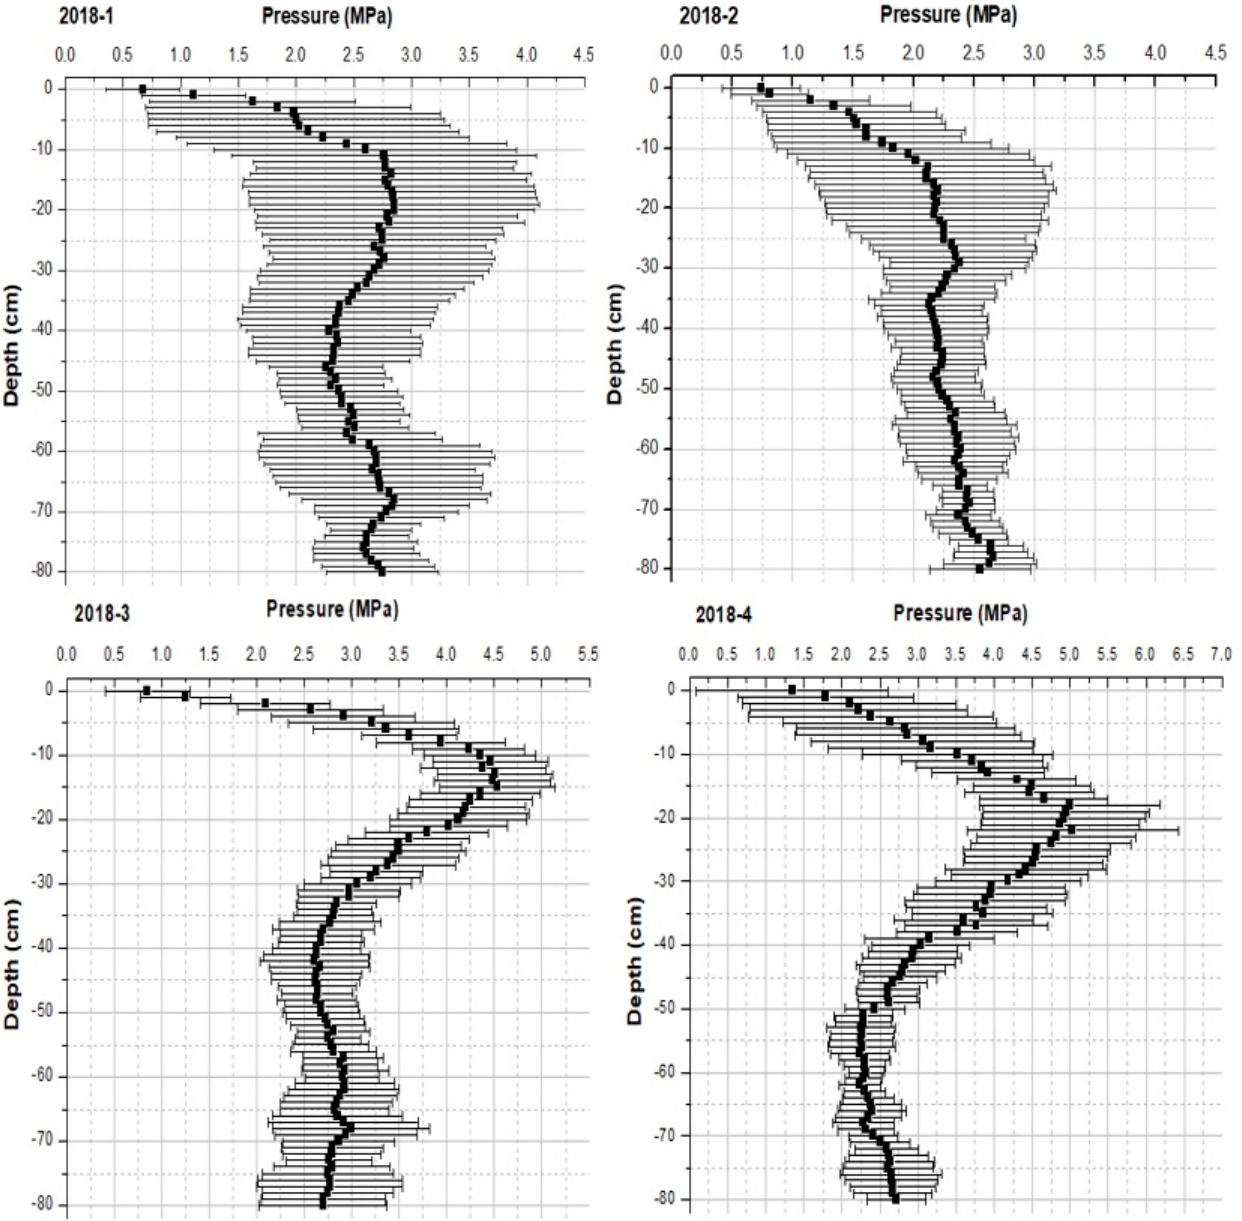
Figure 4. Soil penetration resistance values (average values with SD) in autumn 2018. Treatments were marked with numbers as follows: (1) weed control fabric; (2) weed control fabric + straw; (3) cultivated alfalfa; (4) grassland ( Ő sagárd, Hungary).